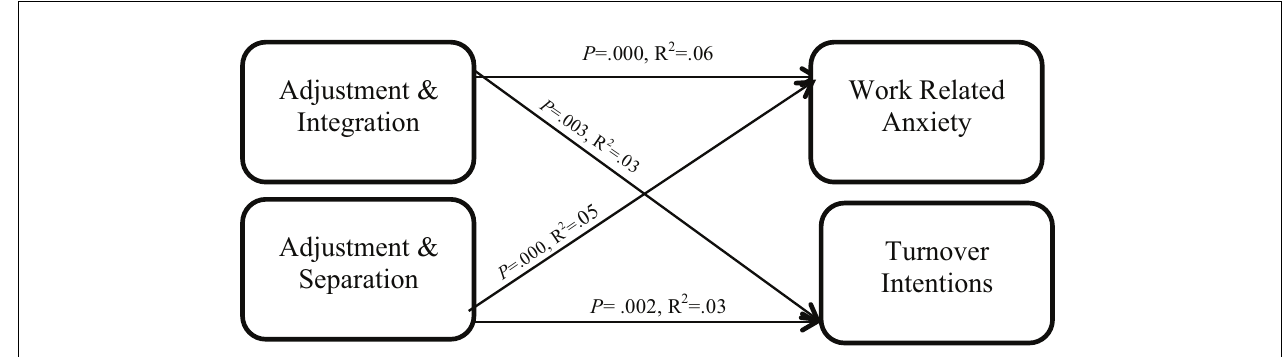
FIGURE 3 | Moderation interaction for work-to-work employees.